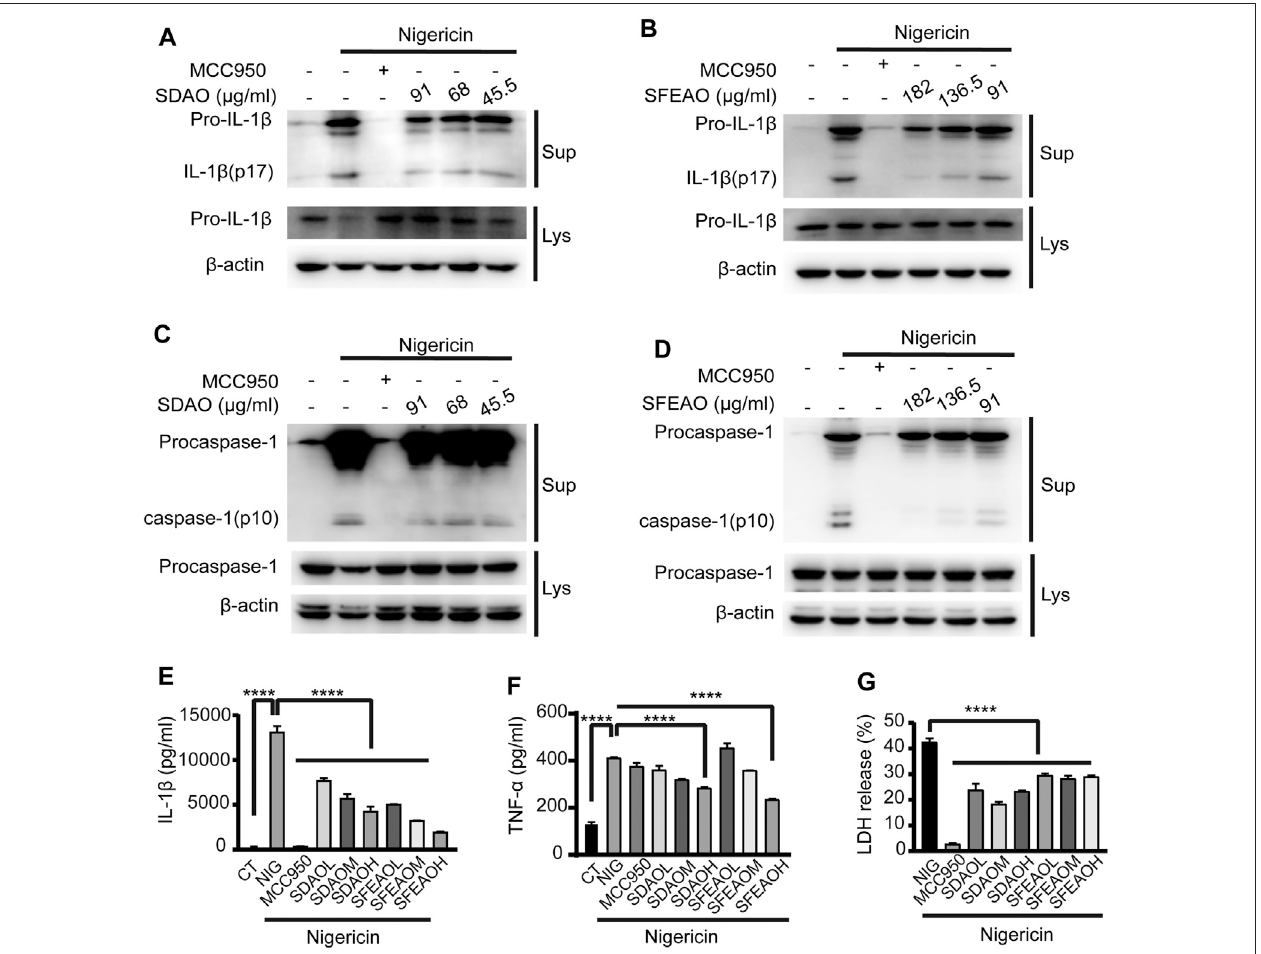
FIGURE 7 | EOAA inhibits the release of processed caspase-1 and IL-1 β induced by nigericin. PMA-primed THP-1 cells were treated with or without MCC950 (20 μ M) or different concentrations of SDAO or SFEAO and stimulated with nigericin (10 μ M) for 1 h. Mature IL-1 β and caspase-1 cleavage were measured in the supernatant. Pro-IL-1 β (A , B) and procaspase-1 (C , D) levels were measured in whole-cell extracts by immunoblotting. β -Actin was used as an internal control. IL-1 β (E) and TNF- α (F) secretion was determined by ELISA. The release of LDH in cell supernatants was assessed by LDH assay (G) . CT:Ctrl; NIG:nigericin; SDAOL, SDAOM, SDAOH mean 45.5, 68, 91 μ g/ml SDAO, respectively; SFEAOL, SFEAOM, SFEAOH mean 91, 138.5, 182 μ g/ml SFEAO, respectively. Data were from three independent experiments with biological duplicates in each ( E , F ; mean and SD of n (cid:2) 6) or from three independent experiments with six biological duplicates in each ( G ; mean and SD of n (cid:2) 18) or were representative of at least three independent experiments (A – D) . Arcsine-square root transformation of the percent data was used for statistical analysis. Statistics were analyzed using one-way ANOVA by Bonferroni post hoc test, * p < 0.05, ** p < 0.01, *** p < 0.001, **** p < 0.0001.